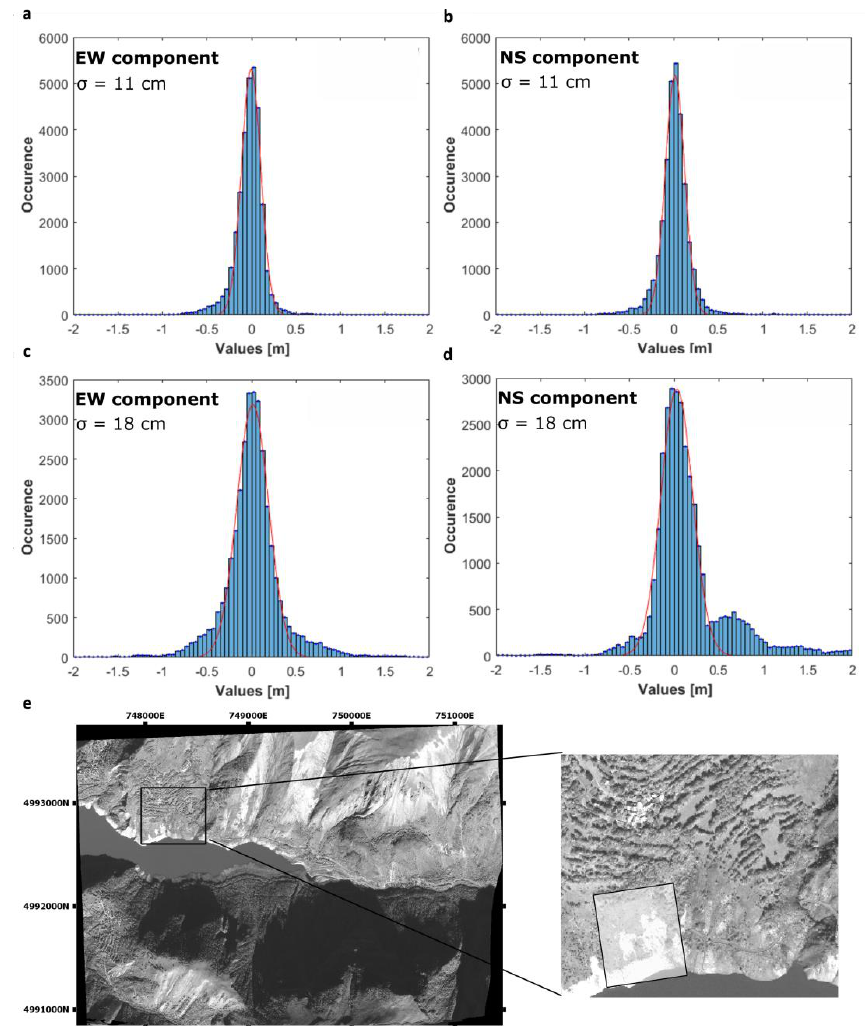
Figure 5. Histograms of the displacement distributions for the EW component and the NS component calculated in a restricted area without taking into account the landslide part represented by the rectangular shape ( e ). ( a,b ) Histograms stem from the correlation between September 2012 and September 2014. ( c,d ) Histograms stem from the correlation between July 2016 and September 2016. Here, σ represents the standard deviation, and the red curve represents the Gaussian fit. ( e ) Zoom-in of the area of interest in which the calculation was performed.